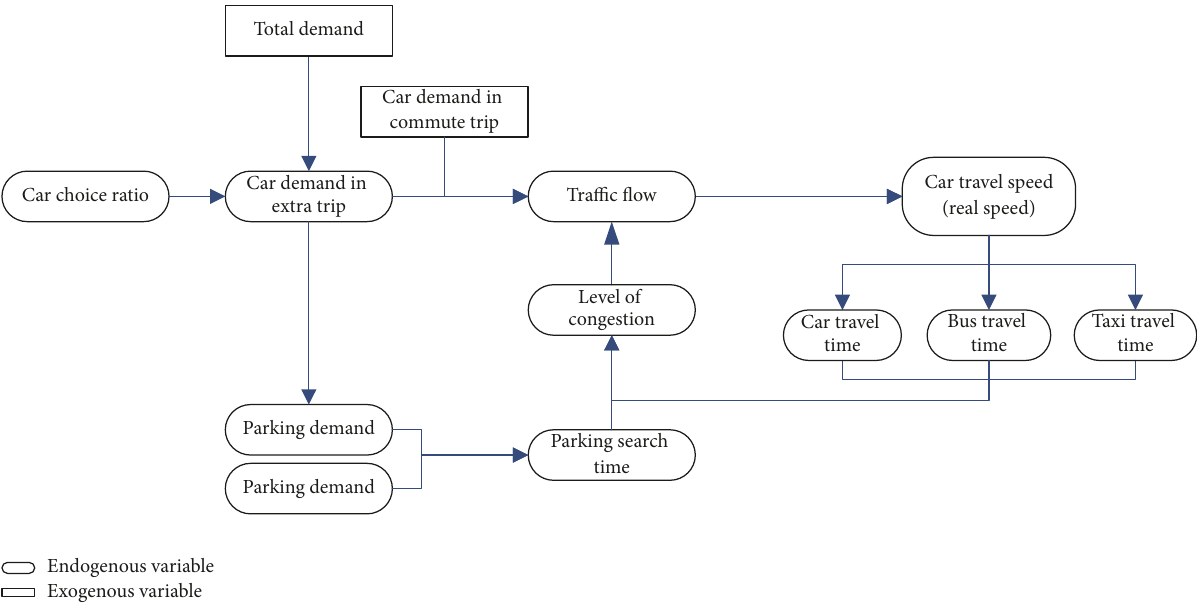
Figure 4: Subsystem for evaluating the state of